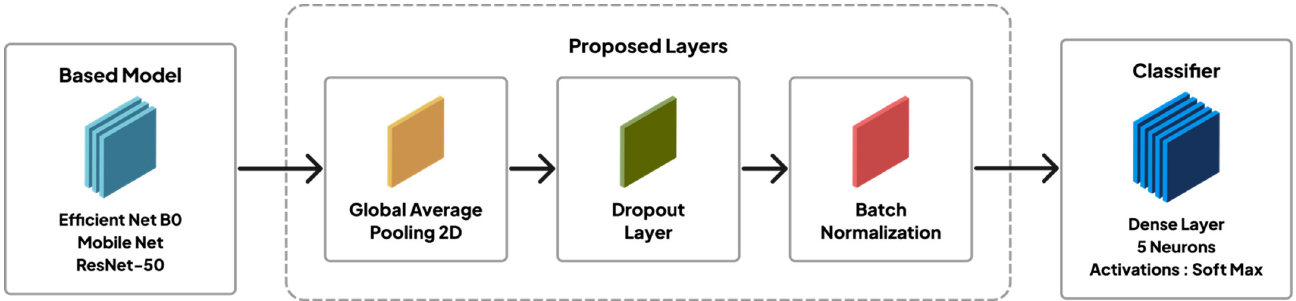
Figure 6. Proposed layers for advanced pretrained model.